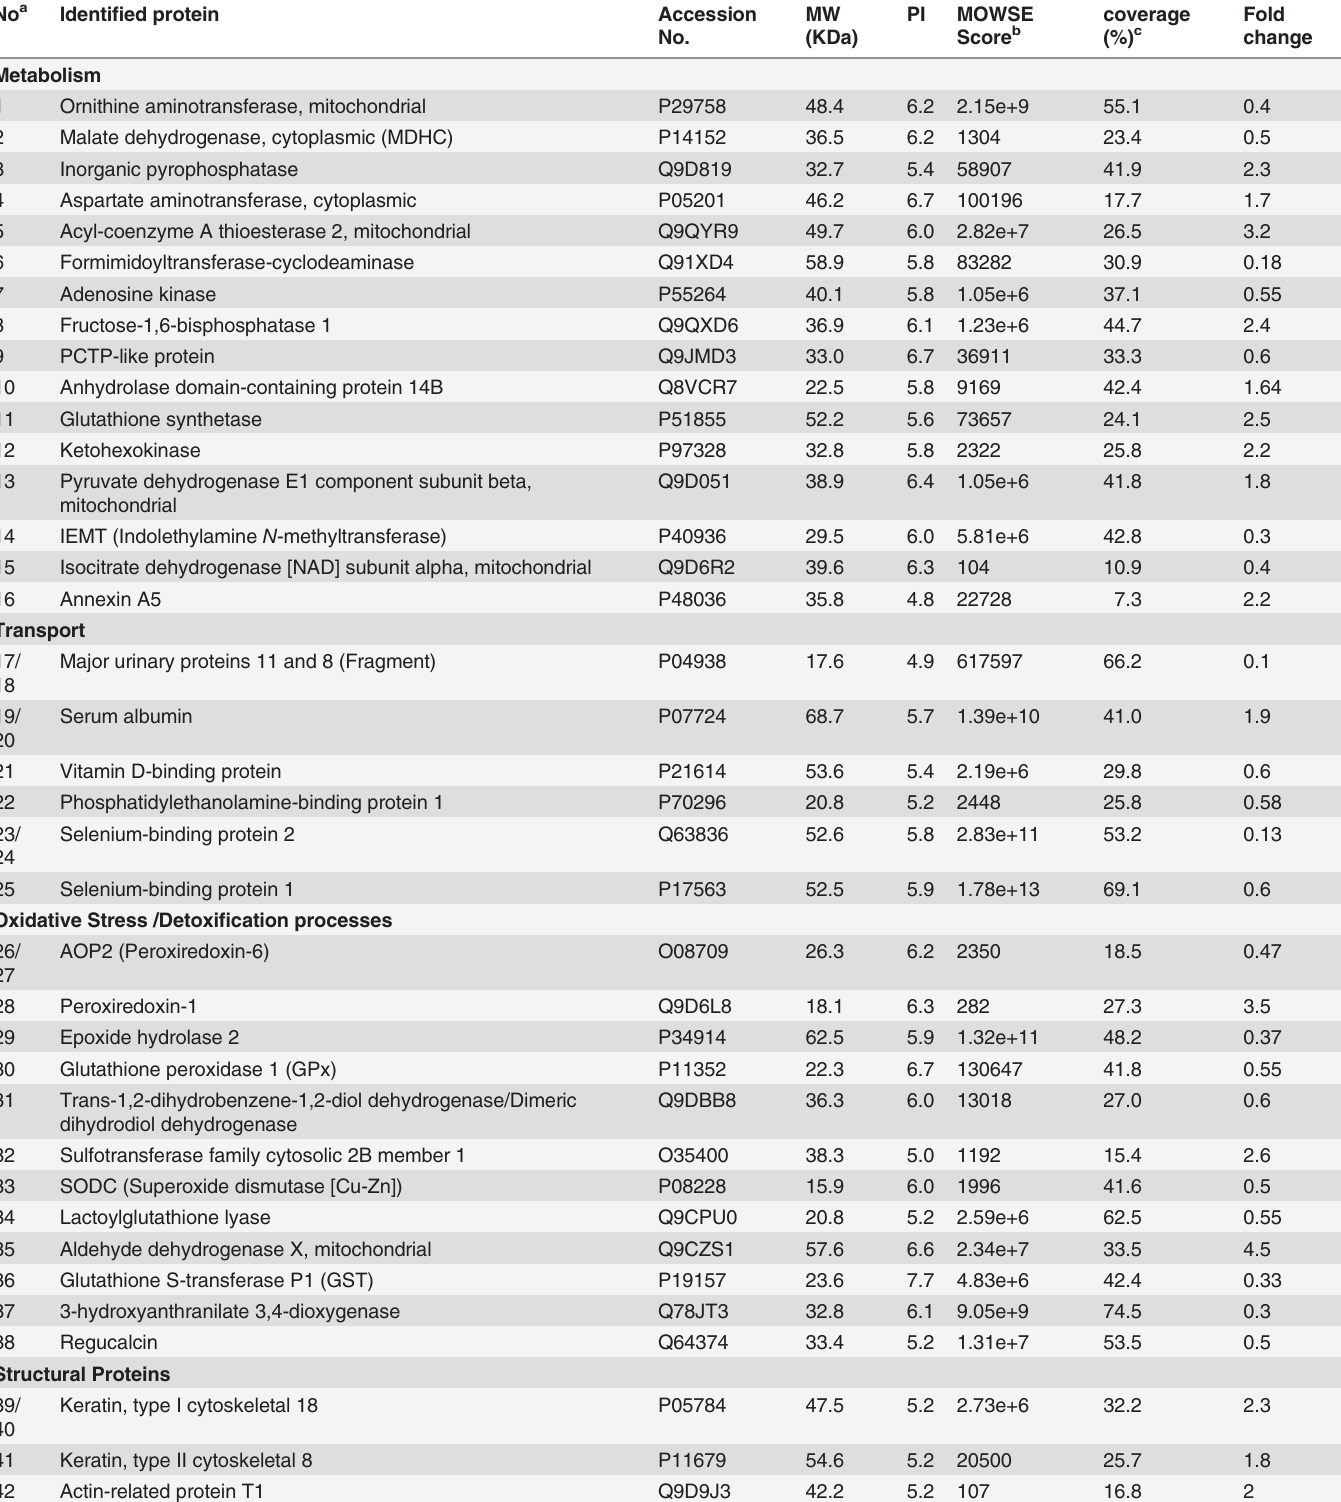
Table 1. List of identified